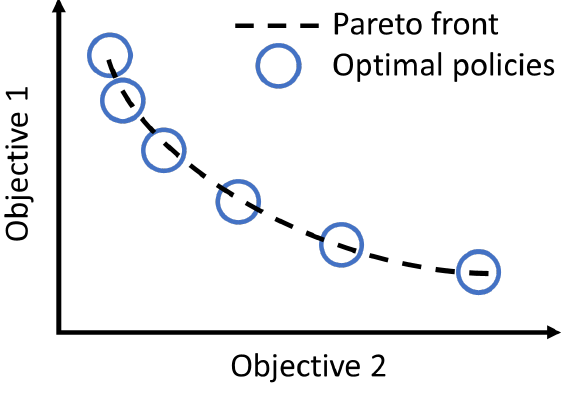
Figure 9. Example Pareto front for a two-objective optimization problem. Solutions along the Pareto front cannot improve one objective without harming the performance of the